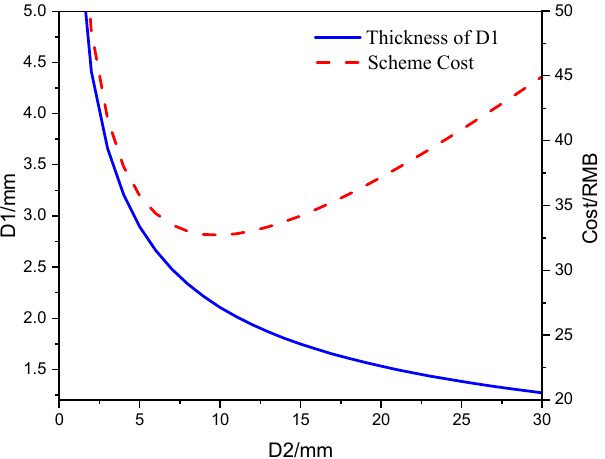
Figure 8. Cost corresponding to the parameter combination scheme.